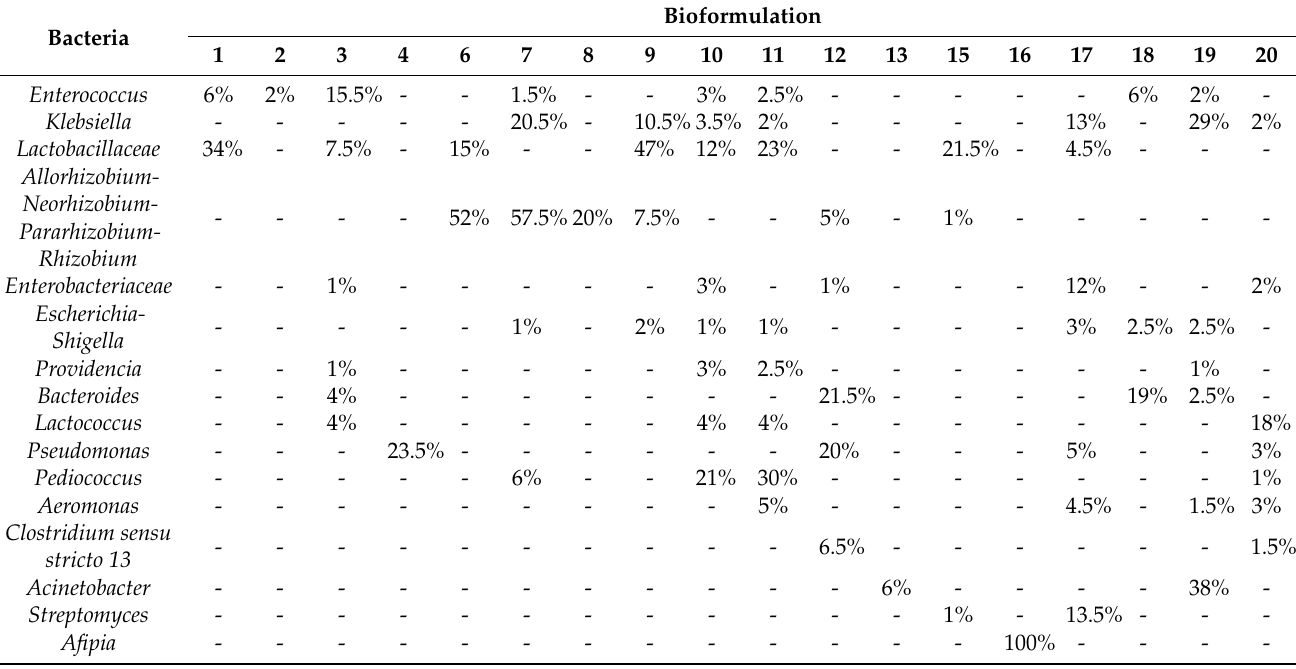
Table 3. Relative abundance (%) of extraneous bacteria in the